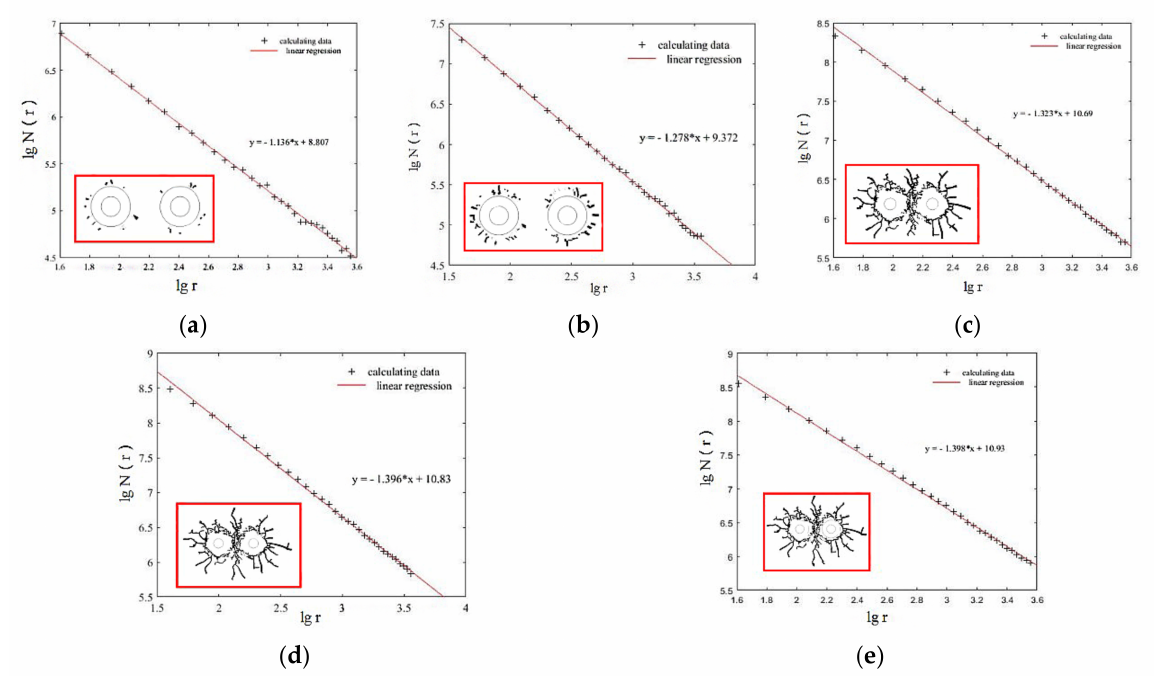
Figure 7. The 110 mm aperture, 770 mm aperture fractal dimension and damage evolution process. ( a ) At 1 us after explosion; ( b ) 2 us after explosion; ( c ) 3 us after explosion; ( d ) 4 us after explosion; ( e ) 5 us after explosion.